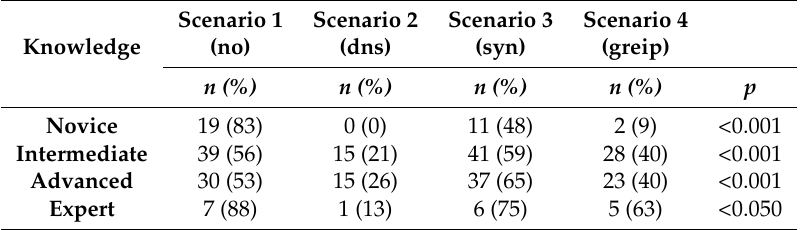
Table 1. Detection accuracy within knowledge level (all scenarios).